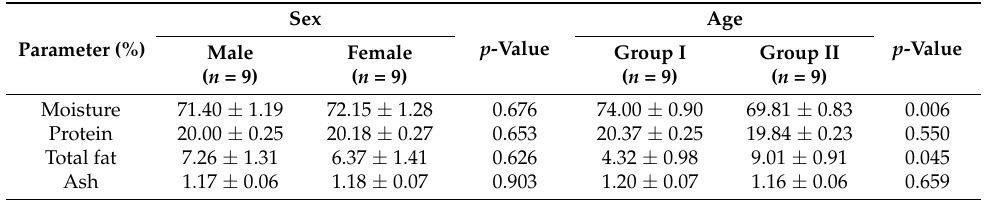
Table 1. Proximate chemical composition of the brown bear, M. semimembranosus , as influenced by sex and age groups (mean ± SE).